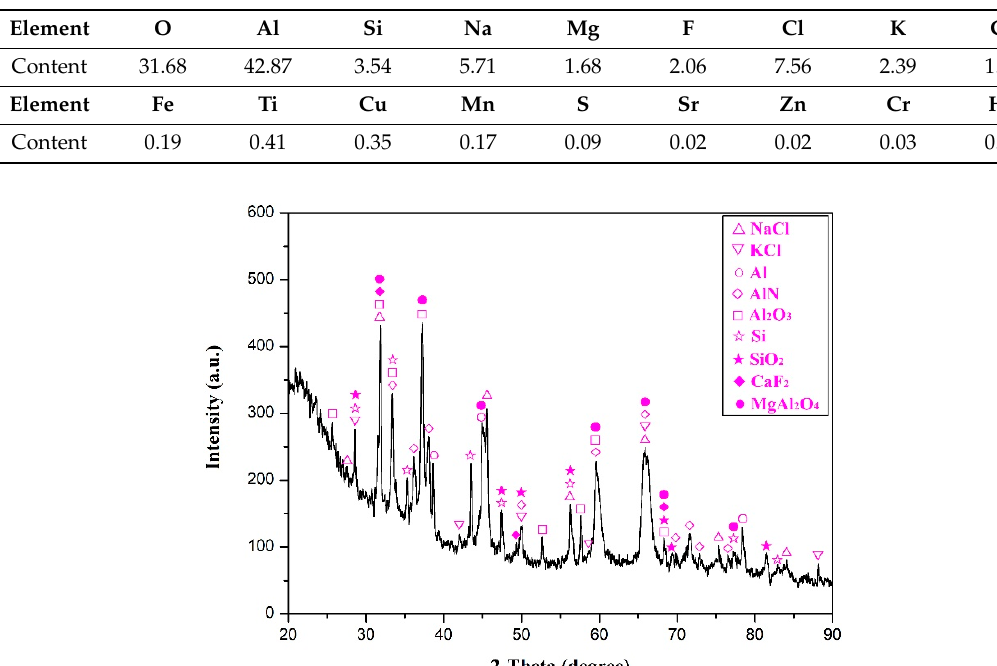
Table 1. Chemical composition of the as-received SAD (wt.%).